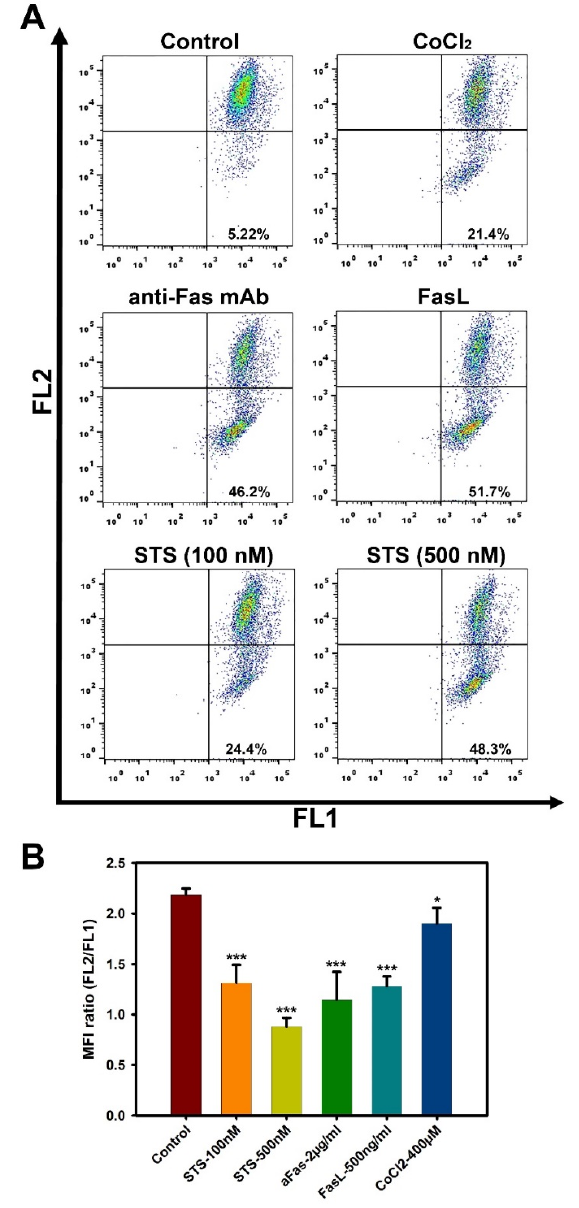
Figure 3. Flow cytometry analysis of mitochondrial membrane potential using JC-1 dye. L-MSCs were incubated with anti-Fas mAb (2 µ g/mL), FasL (500 ng/mL), CoCl 2 (400 µ M), or STS (100 nM and 500 nM) for 4 h. ( A ) Two-parameter histograms of fluorescence intensity distribution in FL1 and FL2 channels. Representative data obtained from a single culture of L-MSCs. ( B ) MFI ratios FL2/FL1. Averaged data from three patient-derived L-MSC cultures. * p < 0.05, *** p < 0.001. Table 1. Percentages (mean ± SEM) of L-MSCs with a decreased mitochondrial membrane